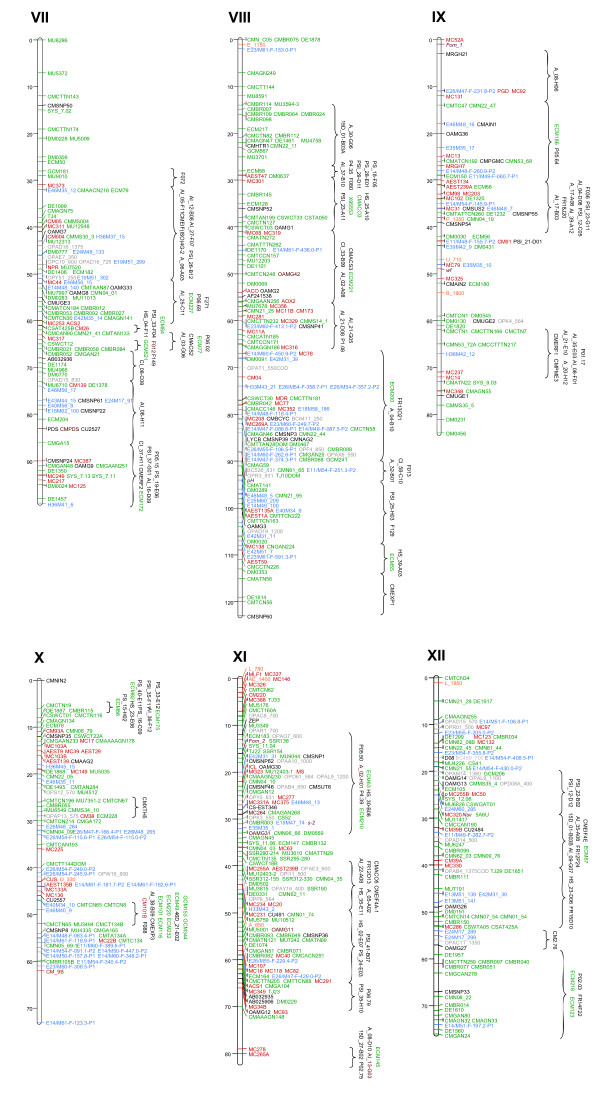
Integrated melon marker map. Linkage groups VII to XII. The remaining six linkage groups of melon (VII-XII). Color code for markers are the same as Figure 1.